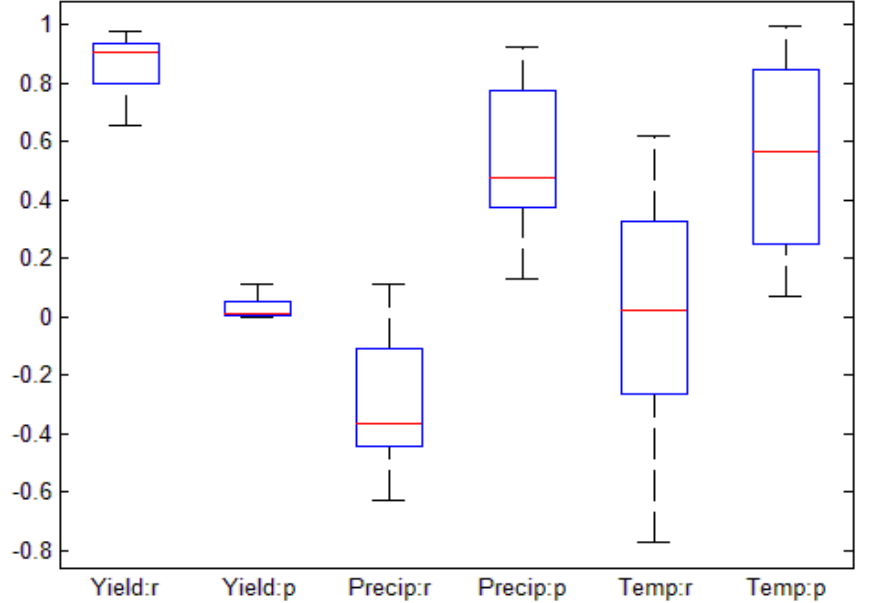
Figure 6. Partial correlation analysis using crop yield data acquired from regional statistical yearbook. “Yield:r” and “Yield:p” refer to the correlation coefficients and p values of the partial correlation between sown area weighted crop yield and accumulated NDVI, with precipitation and temperature as control variables. “Precip:r” and “Precip:p” refer to the correlation coefficients and p values of the partial correlation between NDVI and precipitation, with crop yield and temperature as control variables. ‘Temp:r’ and “Temp:p” represent the correlation coefficients and p values of the partial correlation between NDVI and temperature, with annual precipitation and sown area weighted crop yield as control